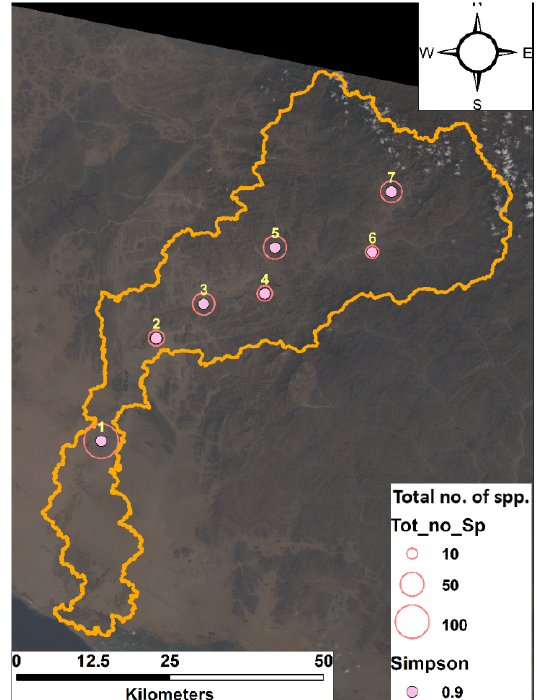
Figure 9. Species richness according to Simpson’s